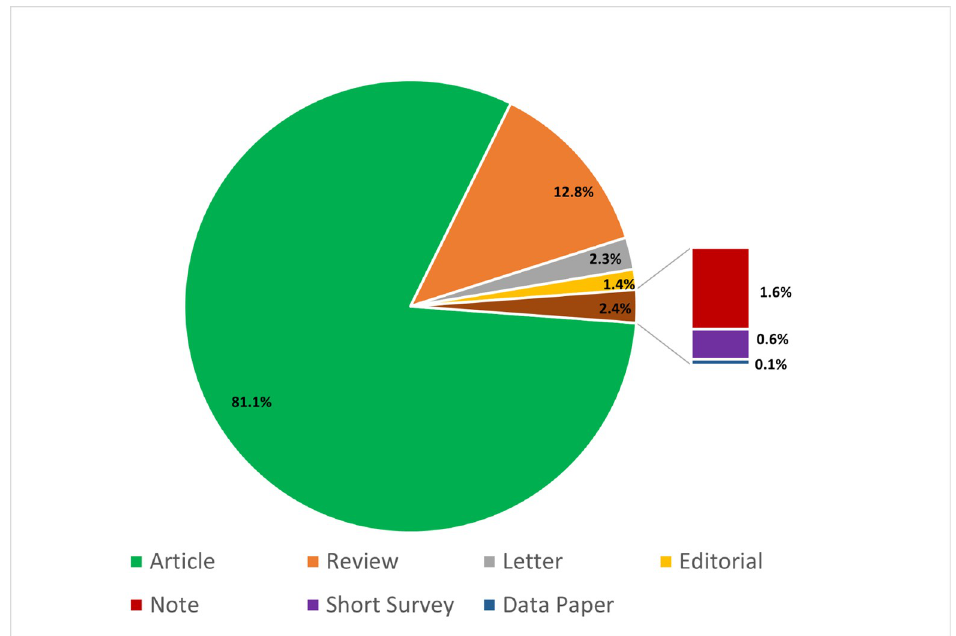
Fig 3. Canadian contribution to NTD publications by publication type (2010–2019). NTD, neglected tropical disease.